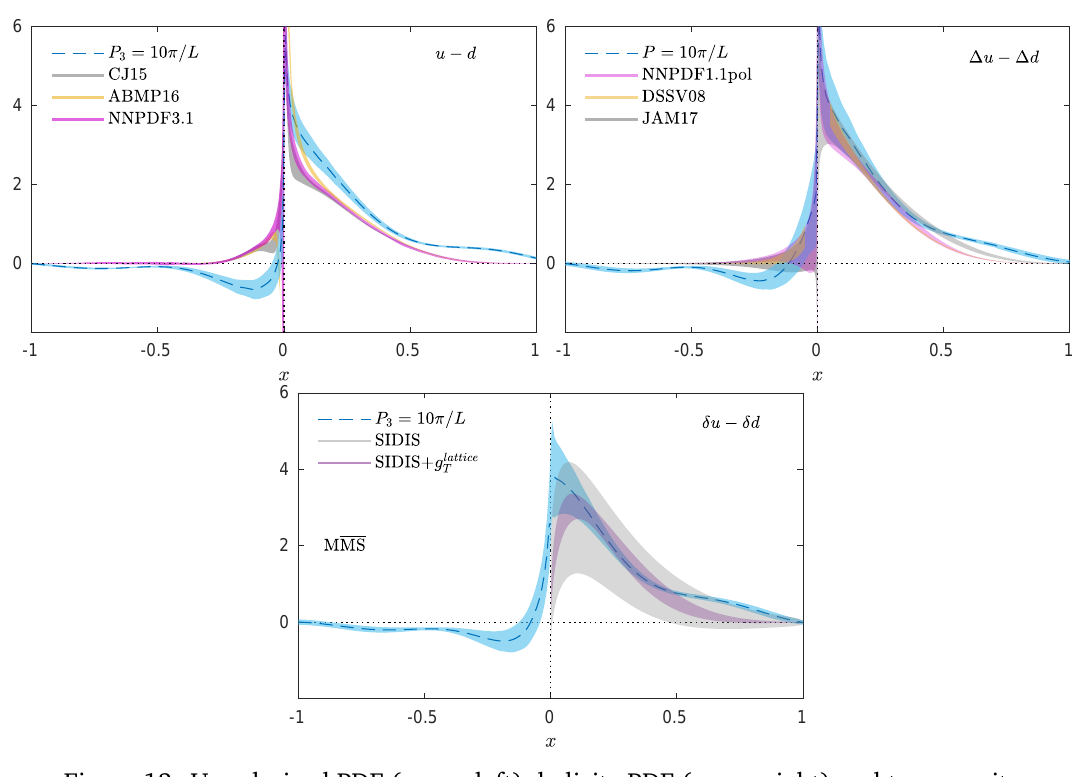
Figure 13: Unpolarized PDF (upper left), helicity PDF (upper right) and transversity PDF (lower)(blue curve). The global fits of Refs. [ 29–31 ] (unpolarized) , Refs. [ 32– 34 ] (helicity) , Refs. [ 35 ] (transversity) are shown for qualitative